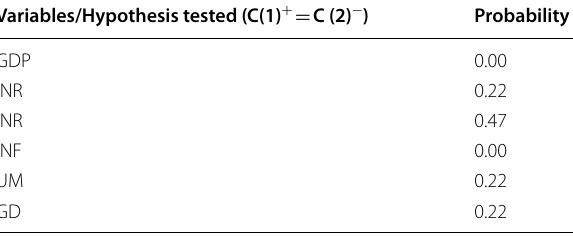
Source: Research